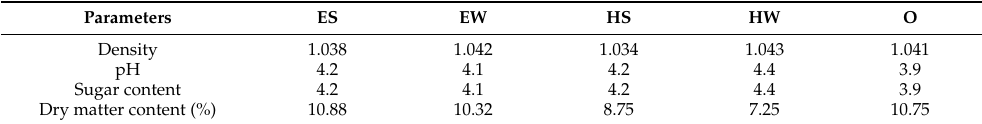
Table 2. Physicochemical evaluation of produced juices and commercial juice.